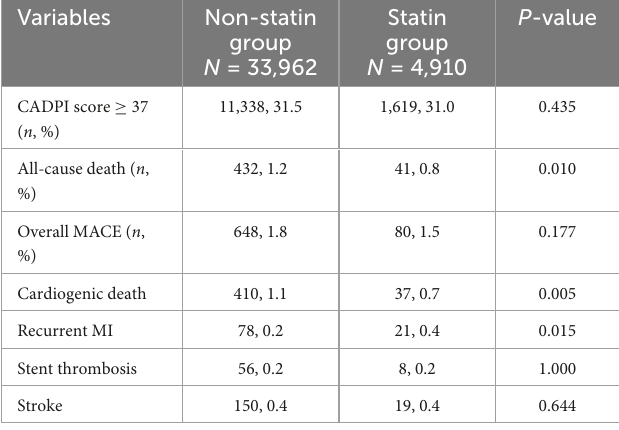
TABLE 2 In-hospital clinical outcomes and CADPI of patients with first ACS.